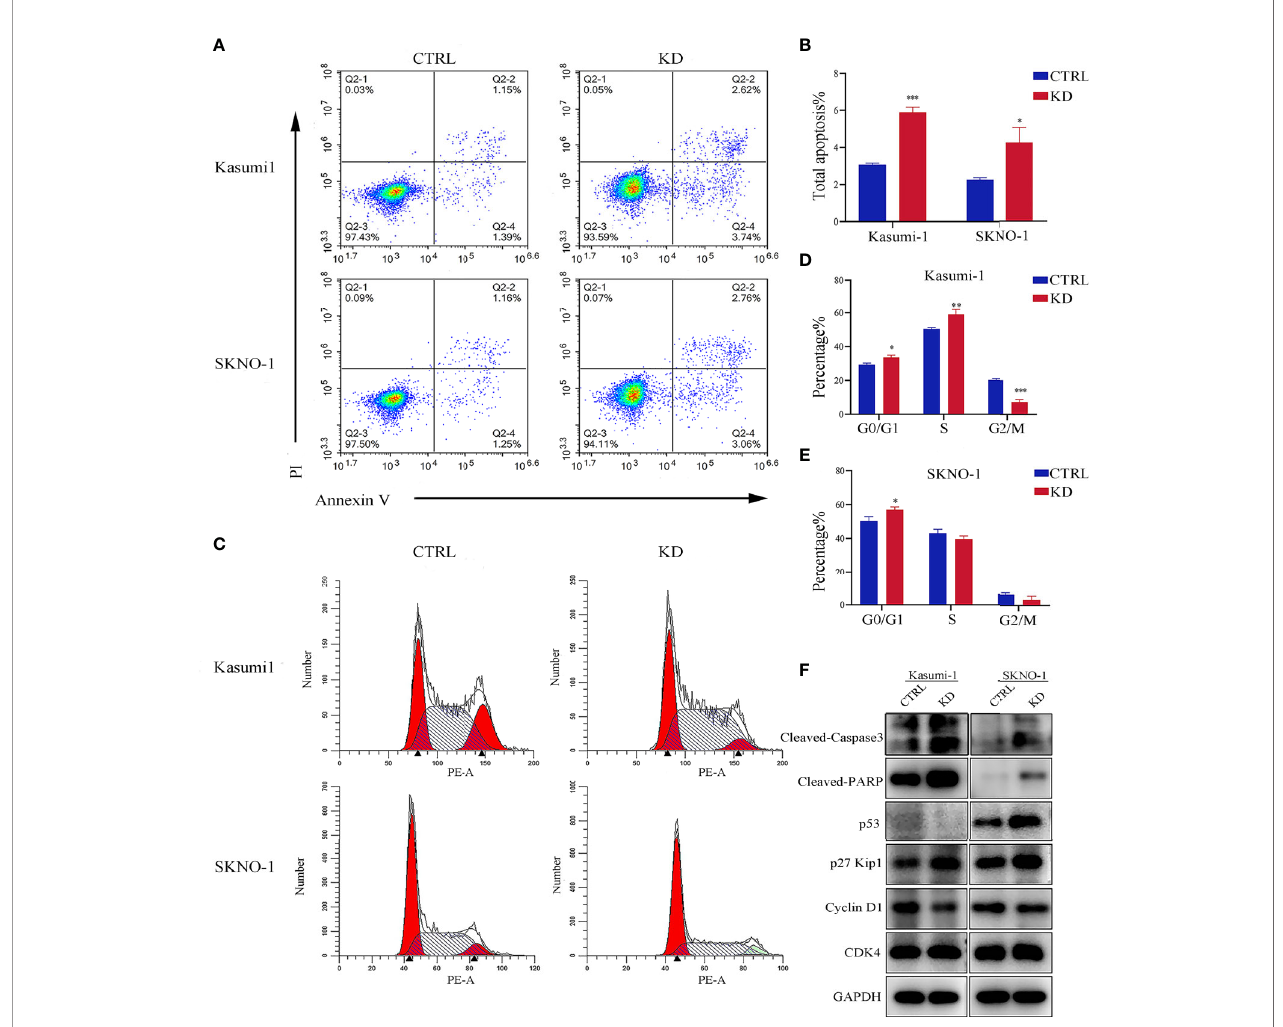
FIGURE 4 | Apoptosis and cell cycle analysis in AML cell lines. (A, B) The fl ow cytometry was utilized to analyze apoptosis in GNA15 knockdown cells compared with control. (C – E) Cell cycle was determined with propidium iodide (PI) staining in CTRL and KD cells. (F) Alterations in apoptosis and cell cycle-related protein assay in GNA15 -KD cells compared to those of their vector controls. CTRL, control; KD, knockdown; * P < 0.05 compared with CTRL cells; ** P < 0.01 compared with CTRL cells; *** P < 0.001 compared with CTRL